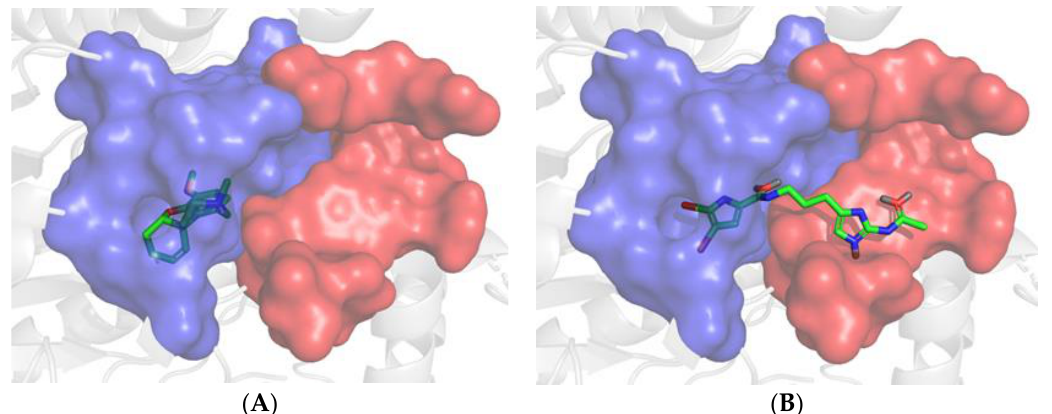
Figure 2. Positioning of galantamine ( A ) and N-acetyl-17-oroidine ( B ) in AChE-active site. Each compound is presented in its most plausible position after protein – ligand docking via GOLD. For the sake of clarity, residue Tyr341, which covers the ligand in the pocket, is left out. The cavity ’ s CAS and PAS regions are depicted in blue and red, respectively. The color codes of the ligand are green for carbon, red for oxygen, and blue for nitrogen atoms. PyMOL was used to draw images.